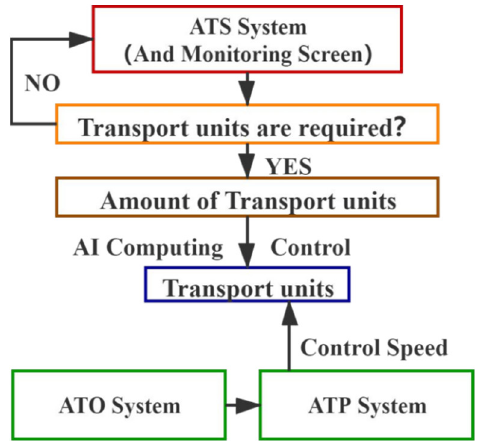
Figure 8. The start-up time control.